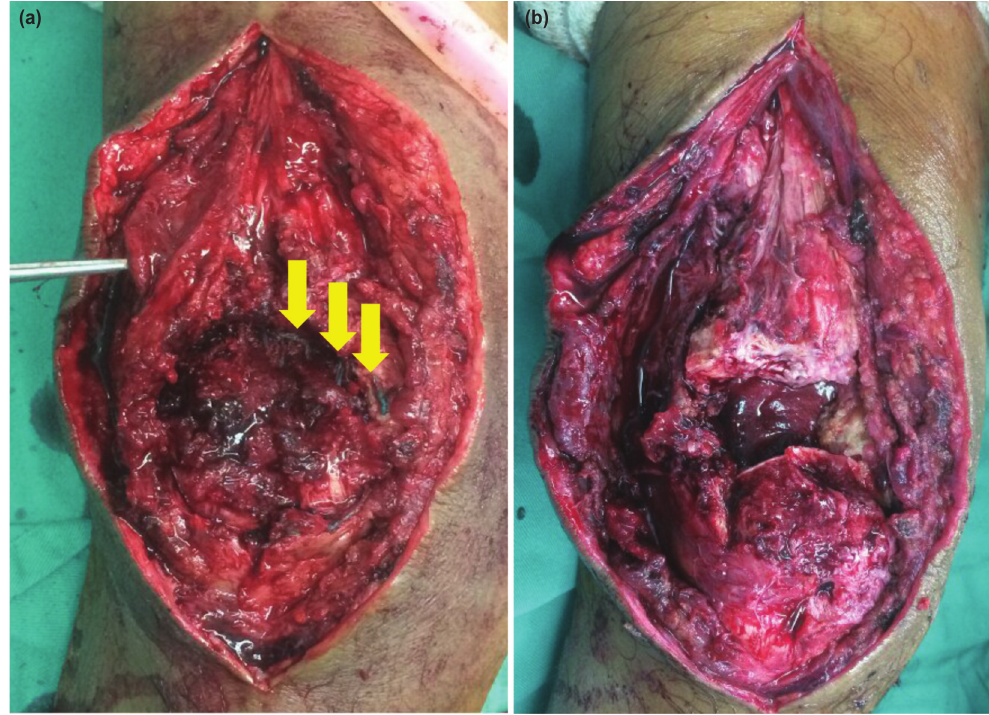
Shows intra-operative findings of recurrent rupture of right knee. (a) Rupture at tendon-bone interface with disrupt suture Fig. 3: material (arrows), (b) appearance after clearing the hematoma and disrupted